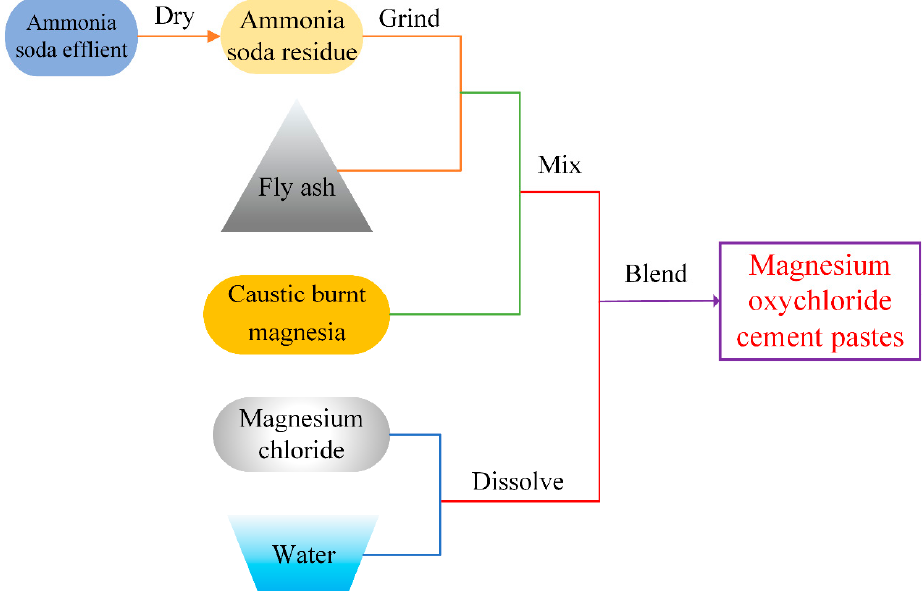
Figure 8. Grinding and mixing processes of ASR and FA.